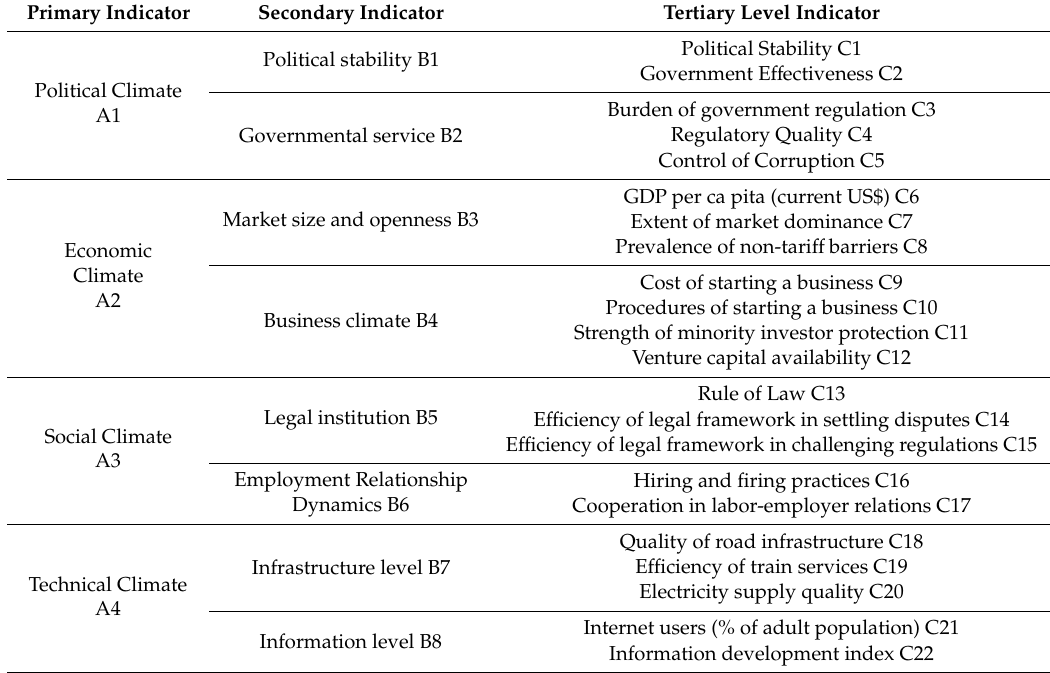
Table 1. Agricultural investment climate evaluation index